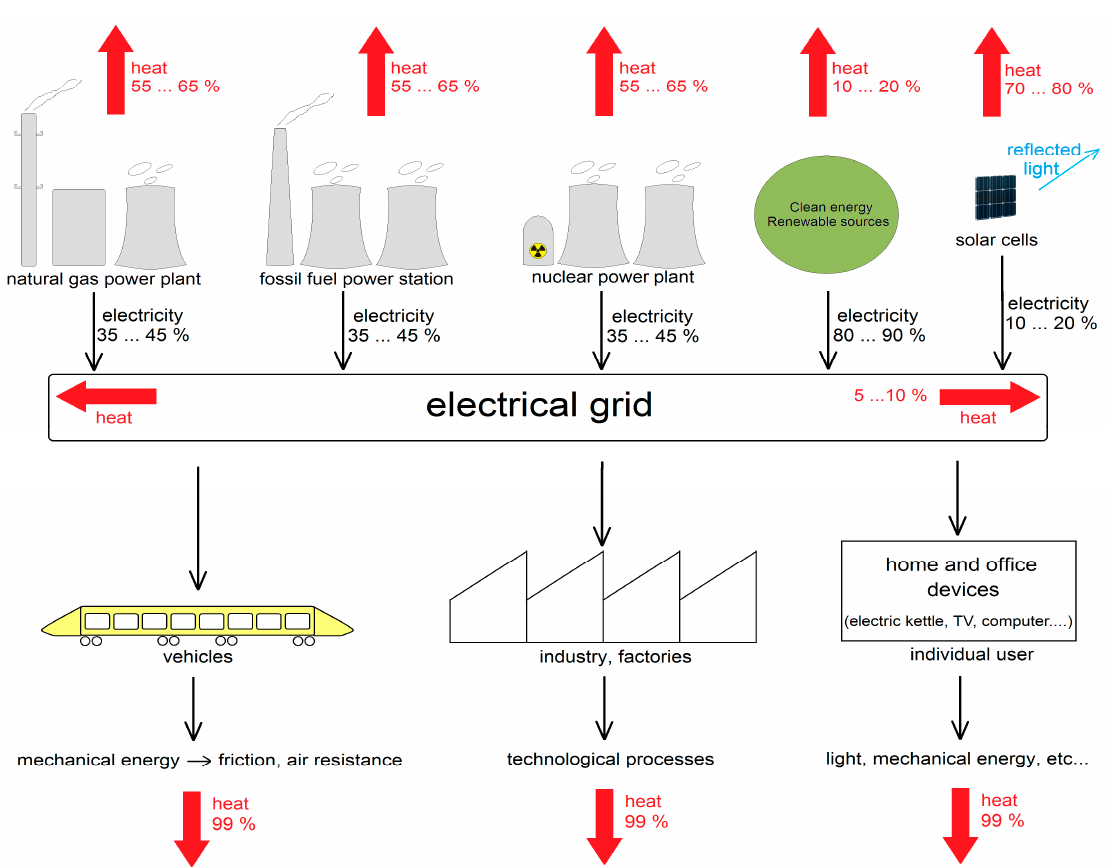
Figure 1. Electrical energy changes into other forms of energy and makes useful work, but almost 100% is finally converted to heat energy (own study).